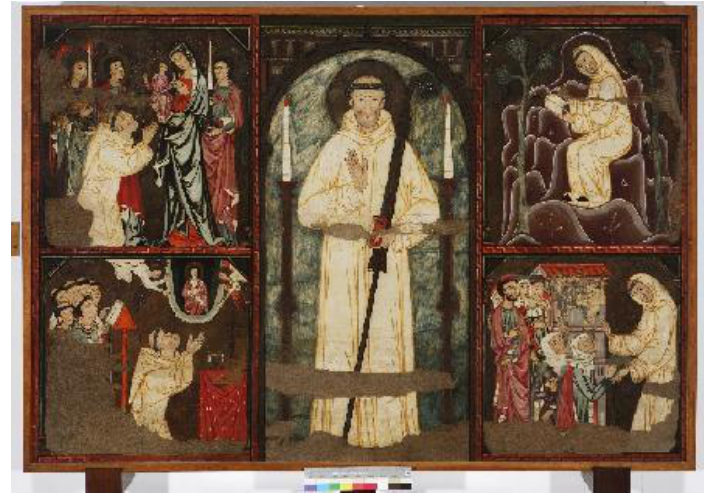
Figure 2. Retaule de Sant Bernat de Claraval. © Museu de Mallorca.